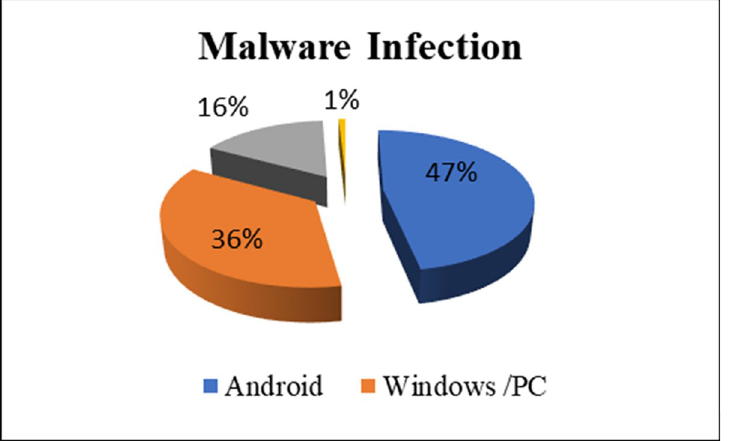
Fig 1. Malware attacks in 2018 by mobile device.